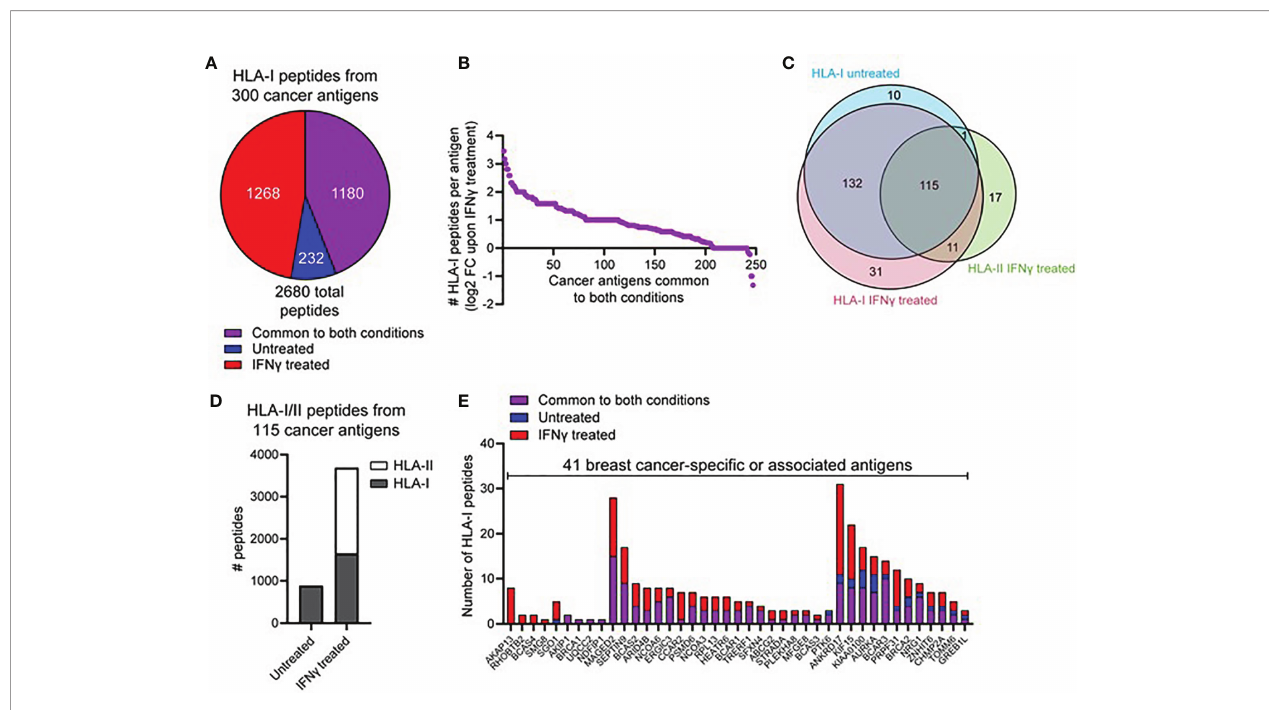
FIGURE 3 | IFN g leads to increased representation of cancer-associated antigens across the HLA-I and -II immunopeptidome. (A) Pie chart showing the total number of HLA-I peptides identi fi ed from 300 cancer-associated antigens (derived from the T antigen, CTdatabase, and breast cancer speci fi c antigens from Uniprot), either unique to untreated, unique to IFN g treated, or common to both conditions. (B) Log 2 fold-change in the number of HLA-I peptides per protein detected following treatment with IFN g . The 245 proteins subset are cancer-associated antigens represented across the HLA-I immunopeptidome under both conditions. (C) Overlap of cancer-associated source proteins across the HLA-I (untreated and IFN g treated) and HLA-II (IFN g treated) immunopeptidomes. (D) The total number of peptides from the 115 commonly identi fi ed cancer-associated antigens within the HLA-I -II immunopeptidomes, under untreated or IFN g treated conditions. (E) A re fi ned subset of speci fi c or associated breast cancer antigens (41 in total), showing the overall distribution of HLA-I peptides identi fi ed across these source proteins. Proteins are ordered based on the conditions they were detected